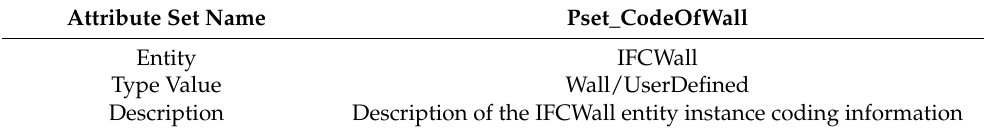
Table 3. IFC wall component code attribute set definition.